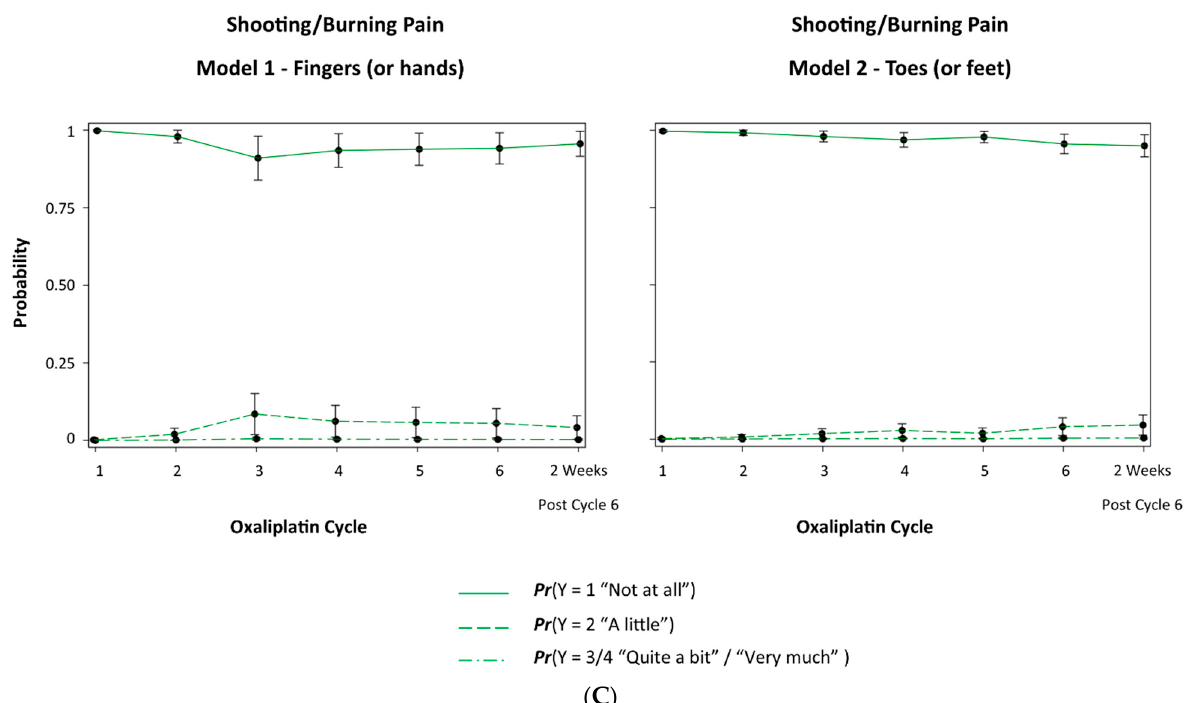
Figure 2. ( A ) Population-averaged probability (averaged over patients) of each ordinal response (Y)—numbness; ( B ) population-averaged probability (averaged over patients) of each ordinal response (Y)—tingling; ( C ) population-averaged probability (averaged over patients) of each ordinal response (Y)—shooting/burning pain—in the fingers (or hands) (LEFT) and in the toes (or feet) (RIGHT).